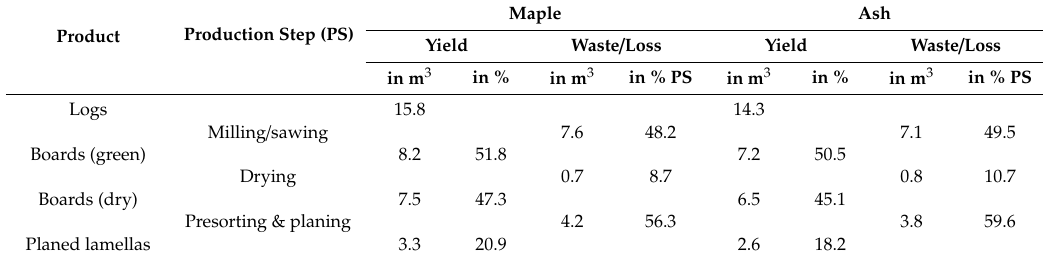
Table 7. Yield for each production step from logs to planed lamellas (unsorted).